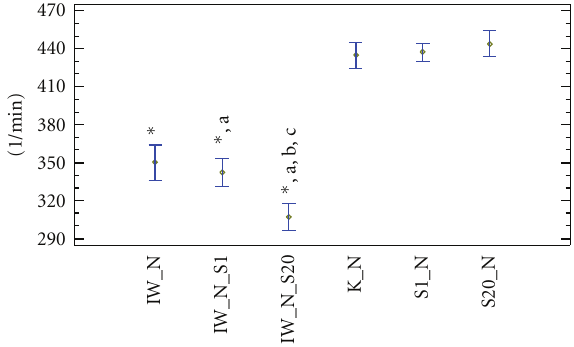
Figure 3: Resting mean heart rate (min − 1 ) in Wistar rats fed nor- mocholesterolaemic diet. K N: normocholesterolaemic control group, IW N: normocholesterolaemic group receiving ivabradine, S1 N: normocholesterolaemic group receiving simvastatin at